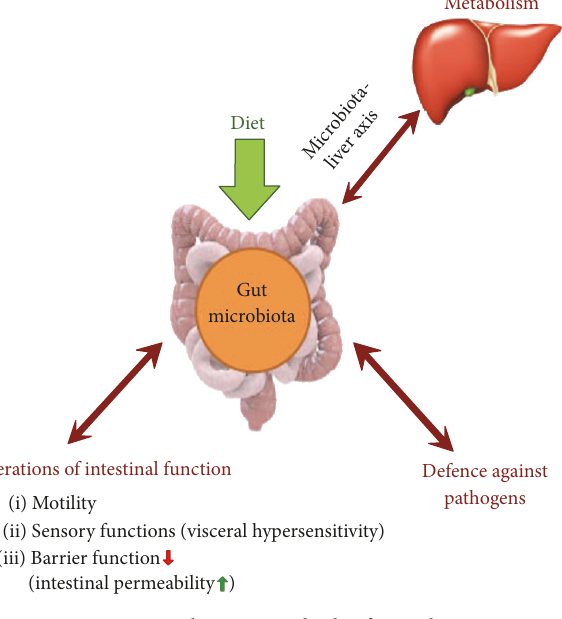
Figure 1: Gut-liver axis and role of